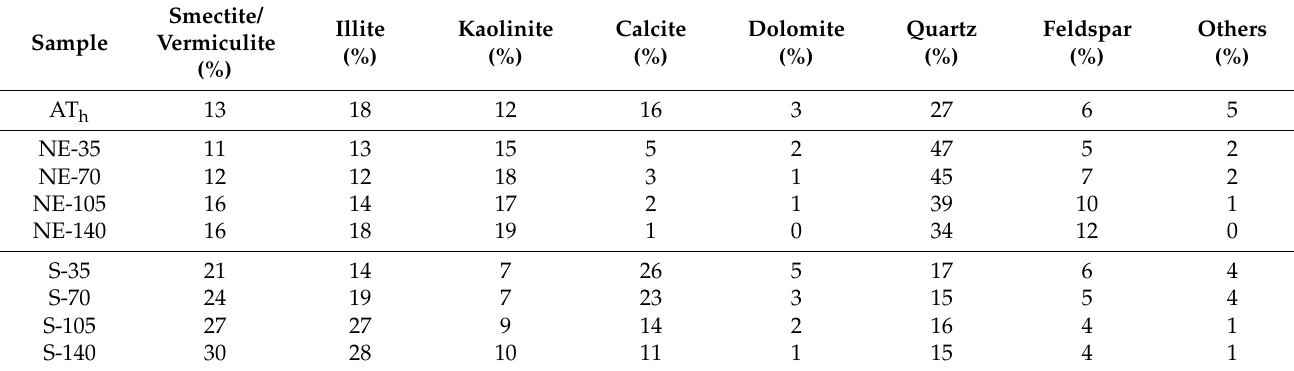
Figure 8. Comparative X-ray diffractograms of Anthrosols and sediments in MDt compartments. Table 4. Mineralogical components for Anthrosols and sediments in MDt compartments.